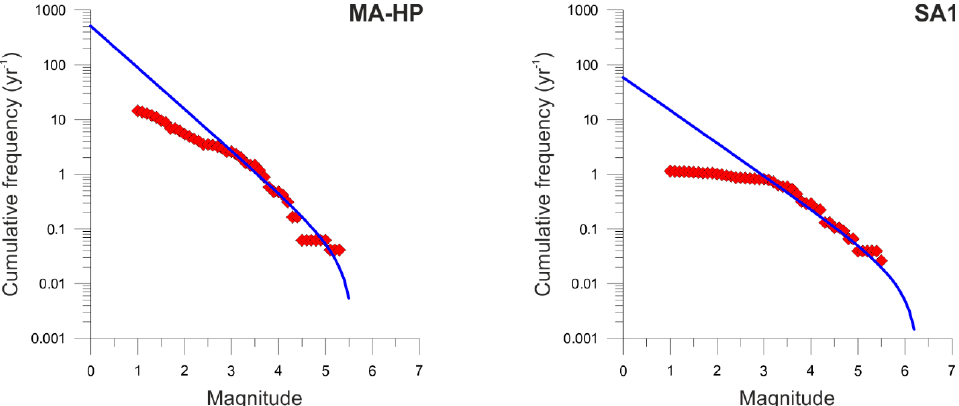
Figure A2. Cumulative frequency-magnitude distributions (red diamonds) of earthquakes for MA-HP and SA1 seismogenic source zones. The blue line represents the truncated Gutenberg–Richter function according to (1).